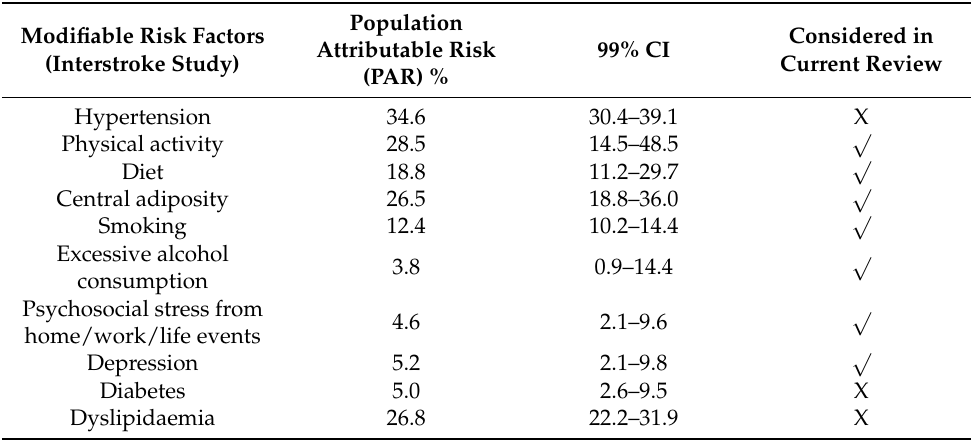
Table 1. Population Attributable Risk Factors for Ischaemic Stroke from the INTERSTROKE study and as included in the current